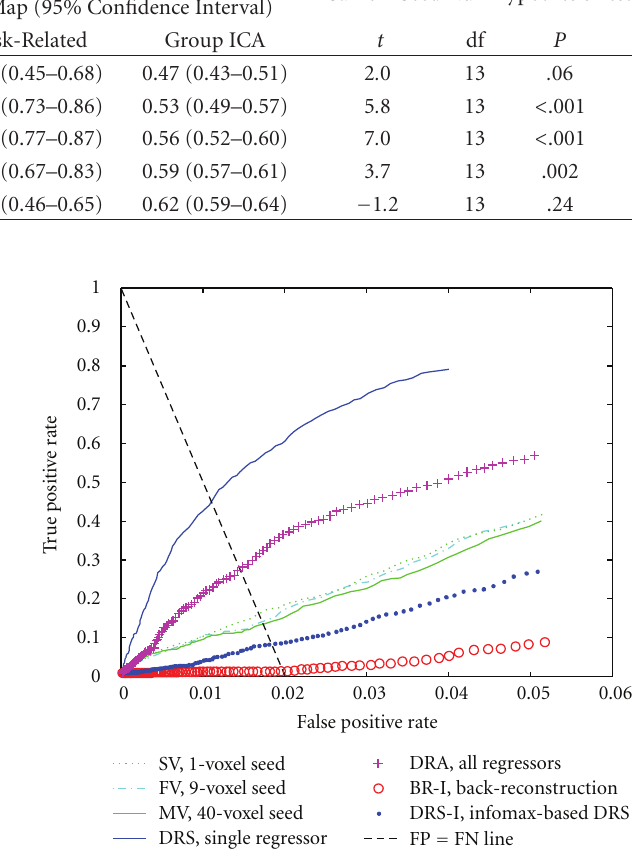
Figure 8: ROC curves for Subject 8, on the interval from 0 to 0.05. Subject 8’s task-related, GLM-derived spatial map was used as the “true” standard of